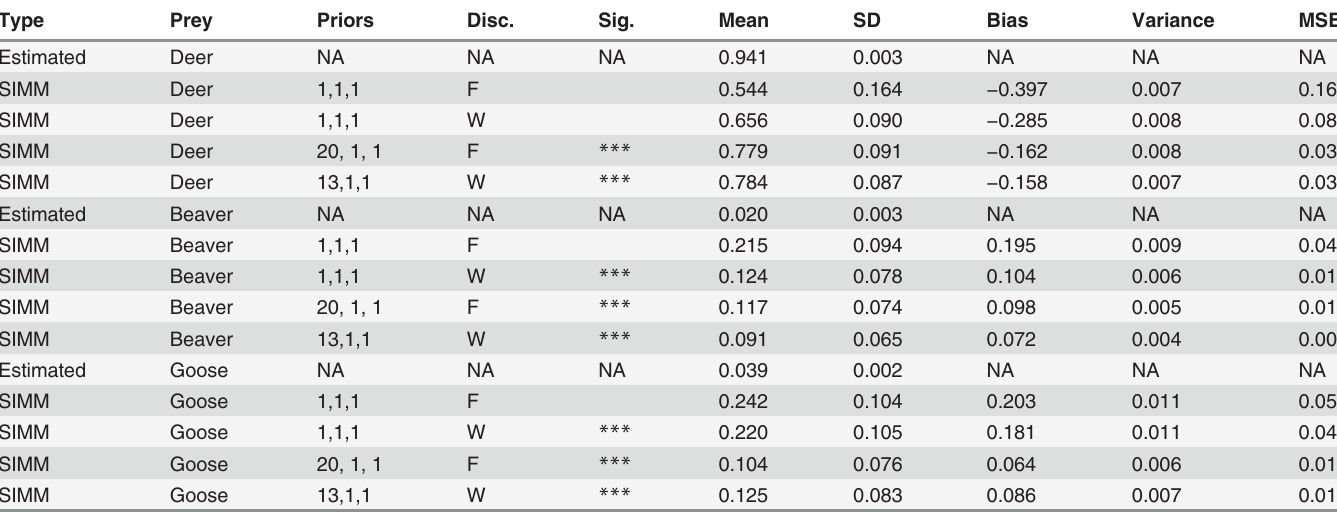
Table 3. Estimates of the proportional contribution of white-tailed deer, beaver, and Canada goose to the diet of gray wolves ( n = 10) during a captive feeding study in Forest Lake, Minnesota, USA, 2011 – 2012. Type Prey